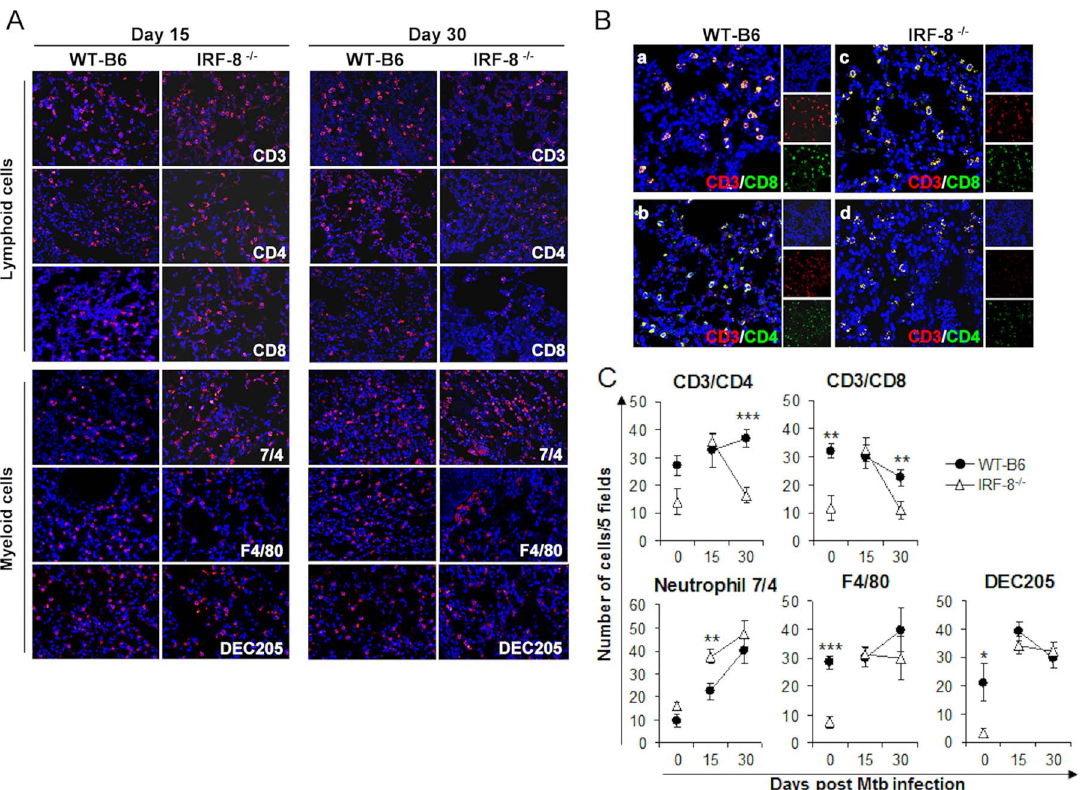
Figure 4. Altered immune infiltration in lungs of Mtb -infected IRF-8 2 / 2 mice. A) Representative CLSM analysis of lung tissues from IRF-8 2 / 2 and WT-B6 mice at days 15 and 30 p.i. stained with a panel of mAbs against the indicated markers B) Representative CLSM analysis of lung sections labeled with anti-CD3 plus either anti-CD4 or anti-CD8 Abs. C) Morphometric analysis cells expressing the indicated markers in each individual lung section. Data express mean cell numbers 6 SD of 5 fields (1 field was 0.16 mm 2 at 400x magnification) of each slide (4–15 slides/mice; n=3 mice/ group) analyzed in lungs of Mtb- infected IRF-8 2 / 2 and WT-B6 and their uninfected counterparts. One representative experiment out of two is shown. * P , 0.05; ** P , 0.01; *** P ,